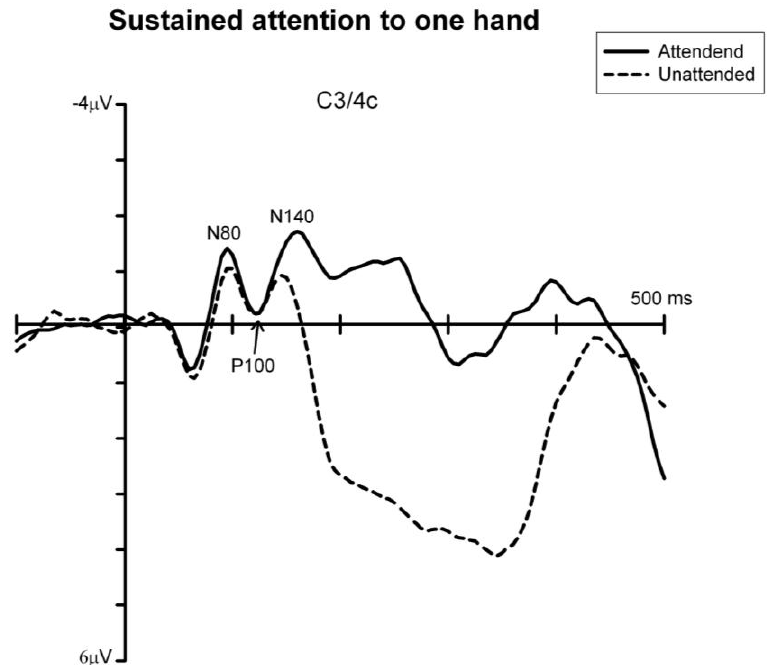
FIGURE 1. Effects of sustained spatial attention on tactile processing.The figure shows grand-averaged somatosensory ERPs elicited in the 500- msec interval following stimulus onset by tactile (mechanical) stimuli at attended ( solid lines ) and unattended ( dashed lines) locations. Somatosensory ERPs are shown for electrode C3/4 (i.e., over somatosensory cortex) contralateral to the site of tactile stimulation. ERPs were significantly enhanced for tactile stimuli presented at attended